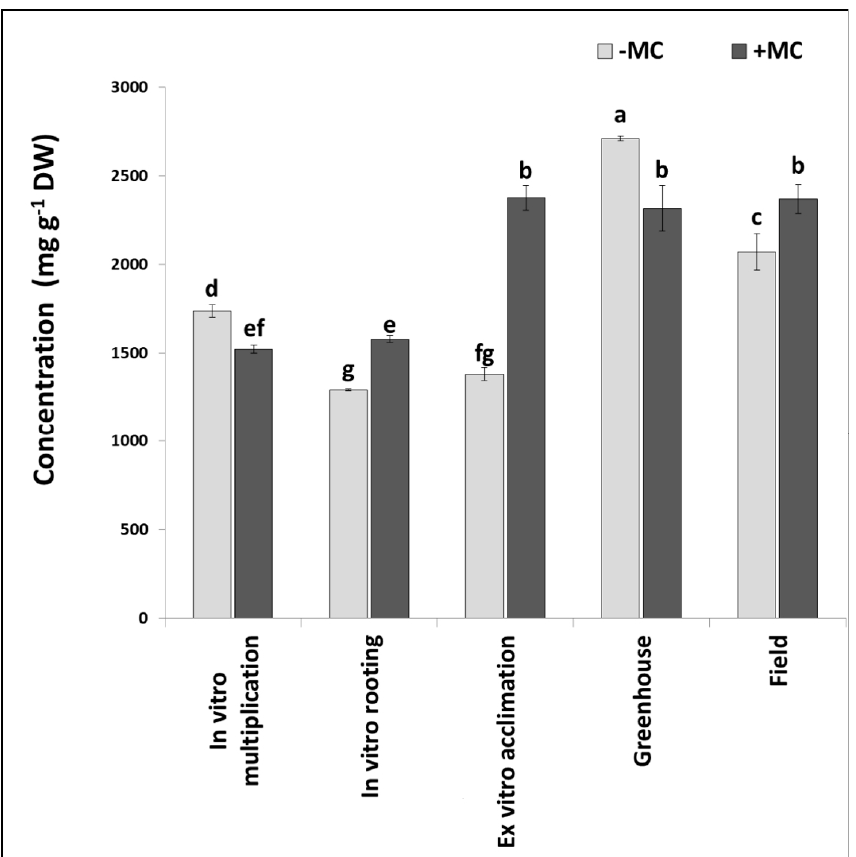
Figure 2. The total phenolic content in the aboveground part of strawberry cv. ‘Solnechnaya polyanka’ plants at different propagation stages without ( − MC) or with mechanocomposite (+MC) treatment. The same lowercase letters for each compound indicate the absence of significant differences in concentration between groups − MC and +MC according to Duncan’s multiple-range test ( p < 0.05). Abbreviations: MC, mechanocomposite; − MC, mechanocomposite free; +MC, mechanocomposite treatment; DW, dry